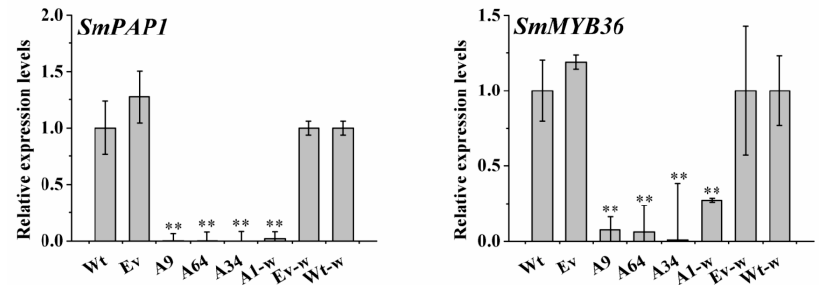
Figure 8. The expression levels of transcription factors in transgenic lines. Wt, the controls that were untransformed wild S. miltiorrhiza plants. Ev, the controls that only transformed the empty vector in S. miltiorrhiza . A9, A64, and A34, three transgenic lines of SmANS -overexpressed in S. miltiorrhiza . A1-w, transgenic line of SmANS -overexpressing in S. miltiorrhiza Bge f. alba . Ev-w, the controls that only transformed the empty vector in S. miltiorrhiza Bge f. alba . Wt-w, the controls that were untransformed wild S. miltiorrhiza Bge f. alba plants. The vertical bars show the SD values from three independent biological replicates. (**) indicated a very significant difference ( p < 0.01).